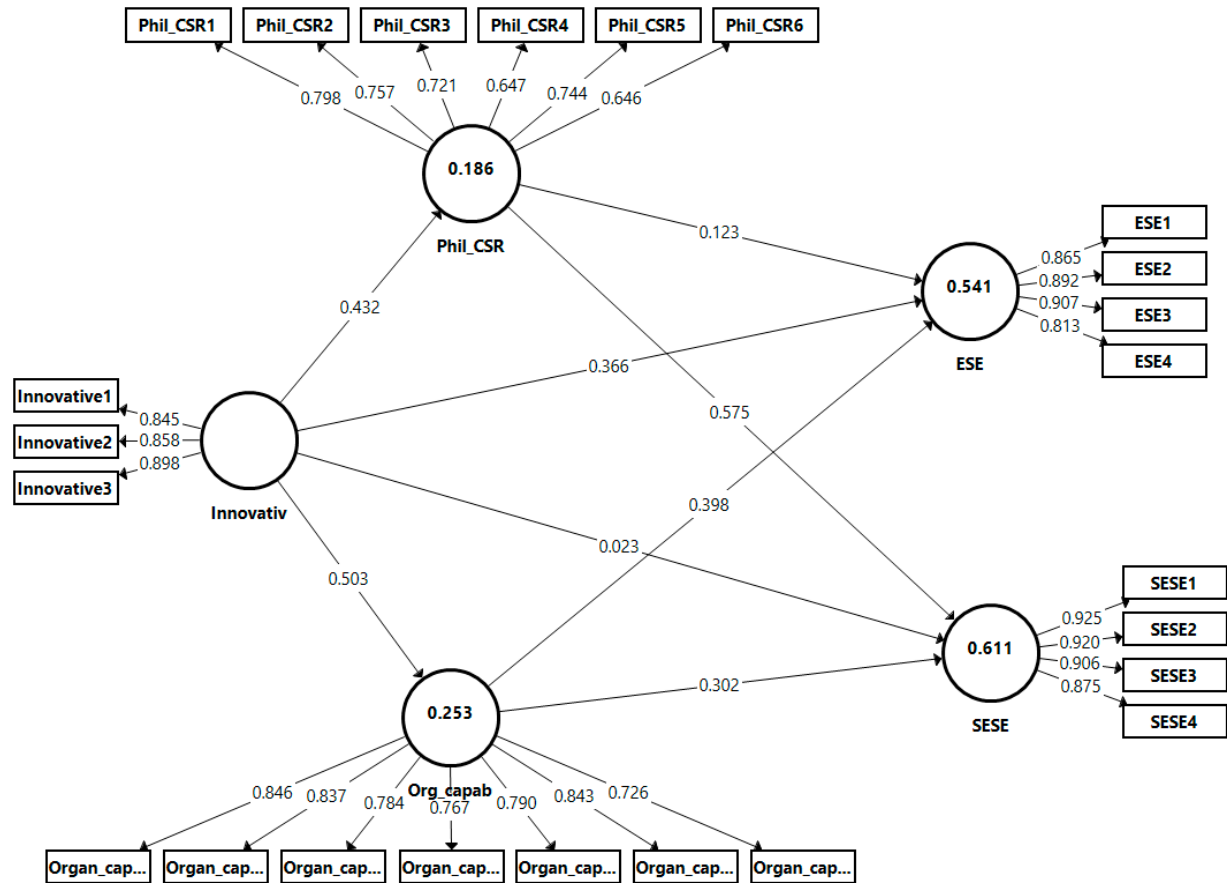
Figure 2. Conceptual model assessment through SEM. Table 1. Composite reliability, average variance extracted, correlations, and discriminant validity checks.